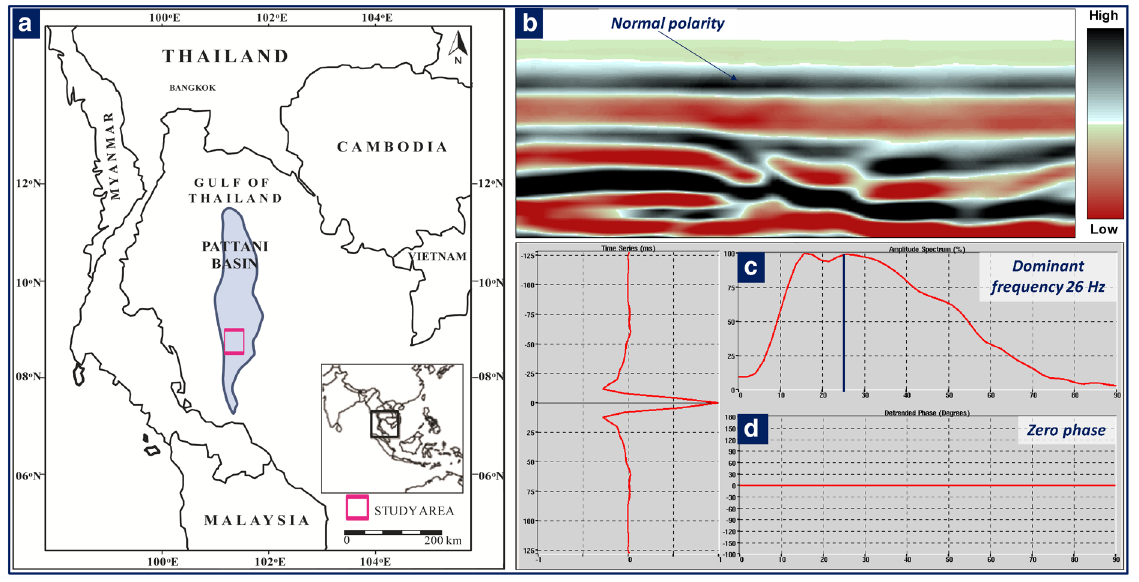
Fig. 1 Location map of the study area ( a , b , c , d ) is showing polarity, dominant frequency, and phase of the 3D seismic